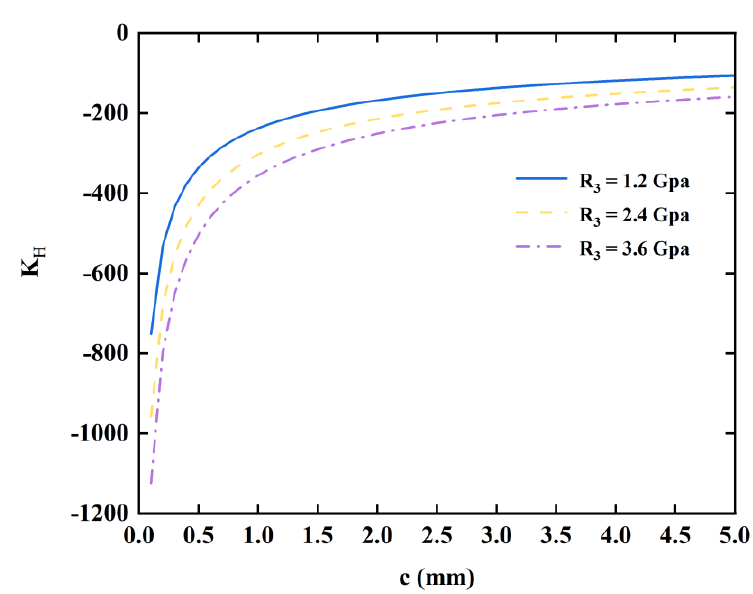
Figure 5. Influence of coupling elastic coefficient R 3 on the phason field stress intensity